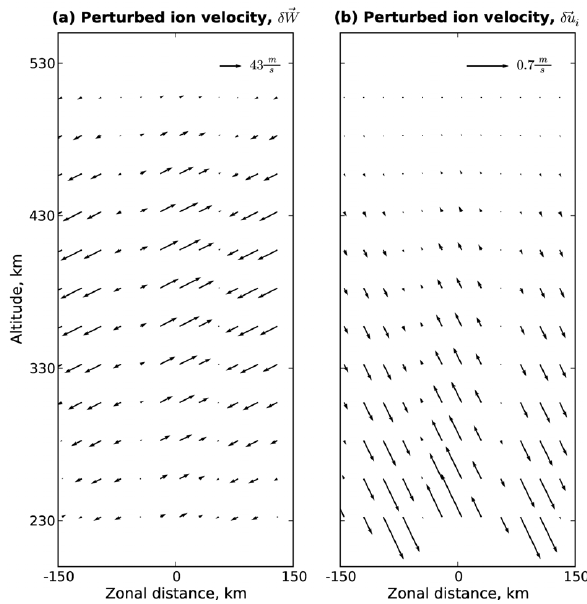
Fig.4 Fig. 4. (a) The distribution of amplitude δW of GW; (b) and the perturbed ion velocity δu i in the F region at t